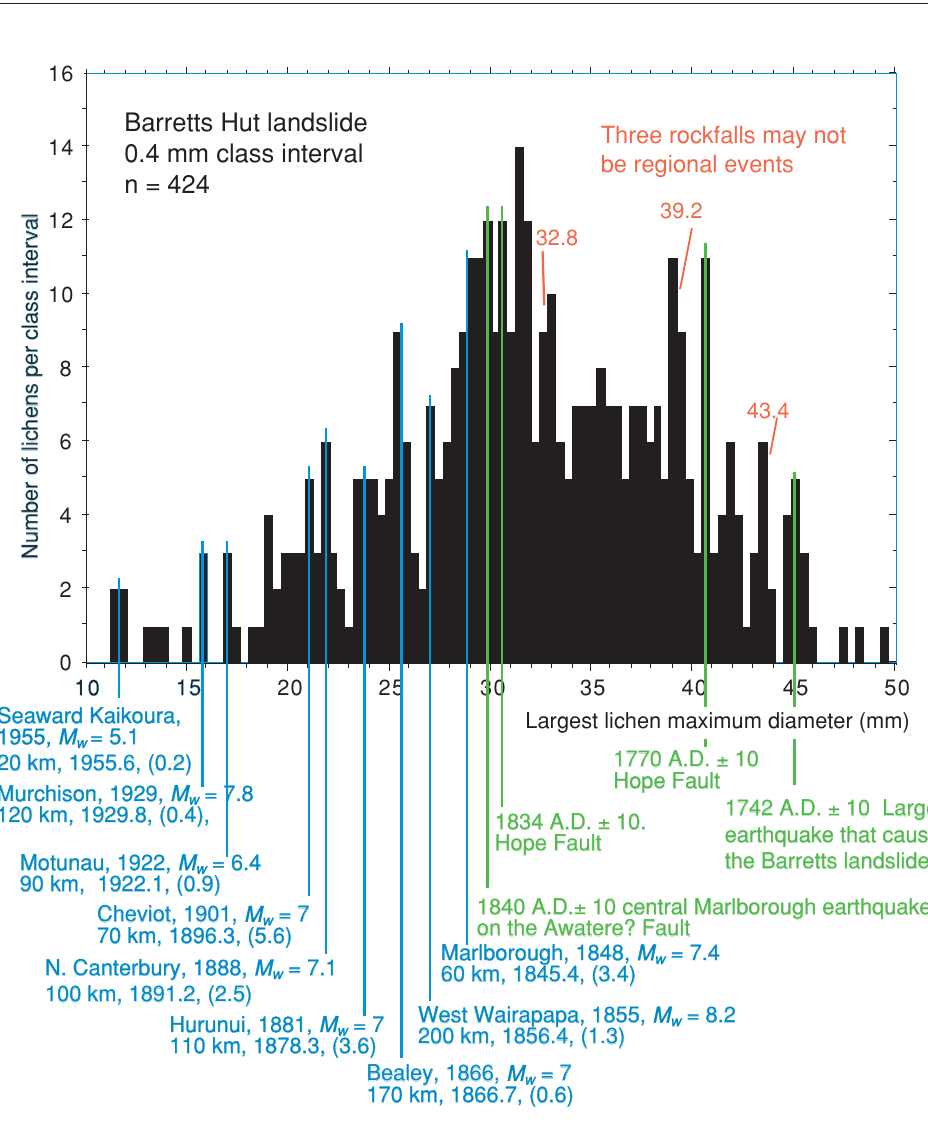
Fig. 6. Histogram of the largest lichen maximum diameters for 424 rockfall blocks. Lichen-size peaks with age estimates that coincide with times of historical earthquakes are shown in blue. Prehistoric earthquakes are shown in green. The time of creation of the Barretts landslide is assigned to the age of the oldest lichen- size